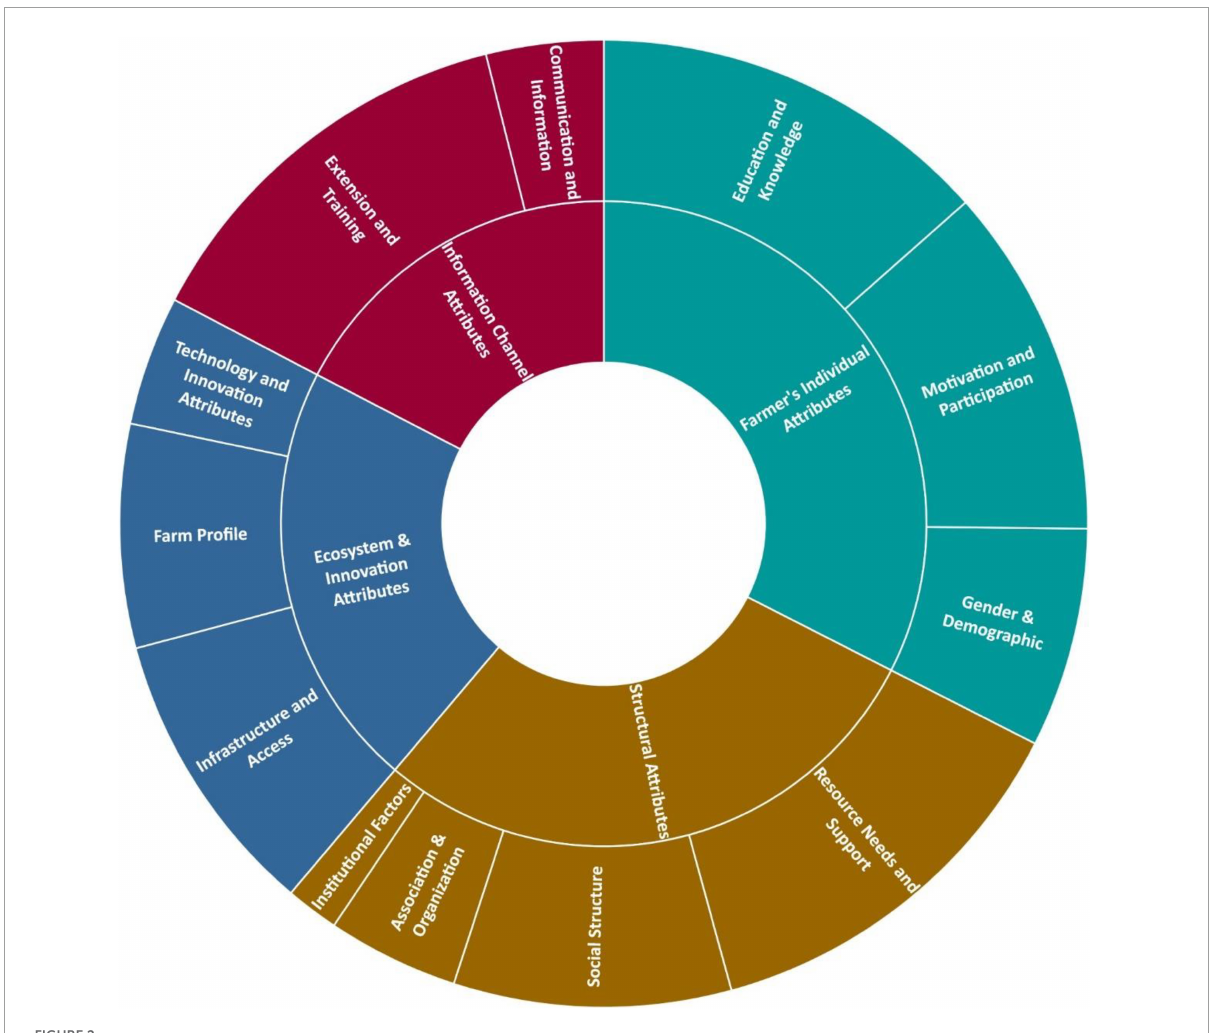
FIGURE2 Summary of determinants of new technology adoption by staple food crop farmers.